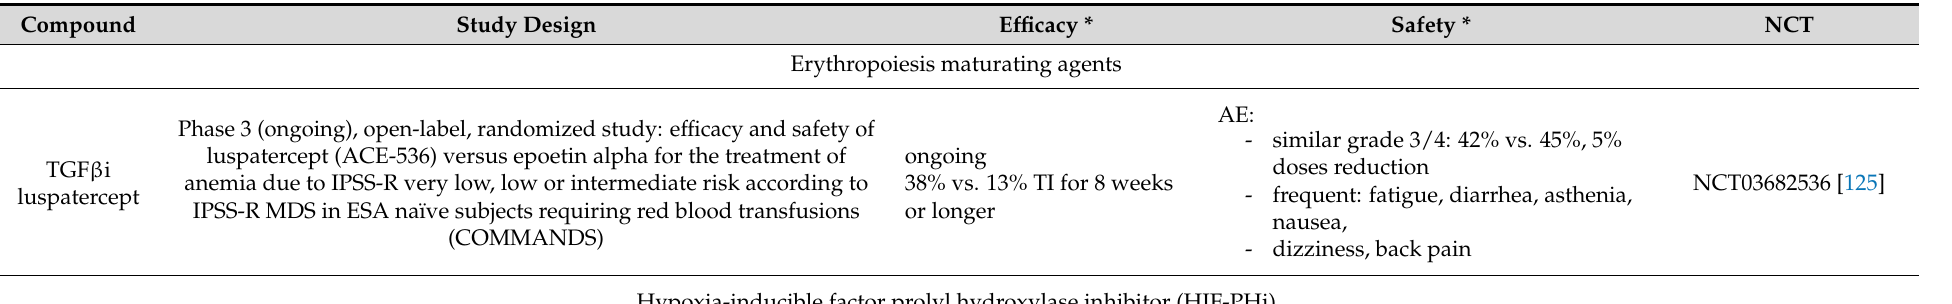
Table 8. Overview on novel targeted and immunotherapeutic options for patients with